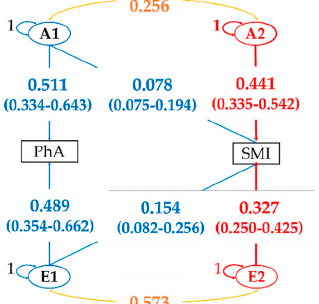
Figure 3. Cholesky decomposition path diagram between phase angle and skeletal muscle mass index for the AE model. Standardized path coefficients are presented. Numbers in parentheses are 95% confidence intervals of estimates. The number between (A1) and (A2) and the number between (E1) and (E2) are correlation coefficients. (A1–2) Additive genetic factor; (E1–2) Non-shared environmental factor; PhA: Phase angle; SMI: Skeletal muscle mass index.